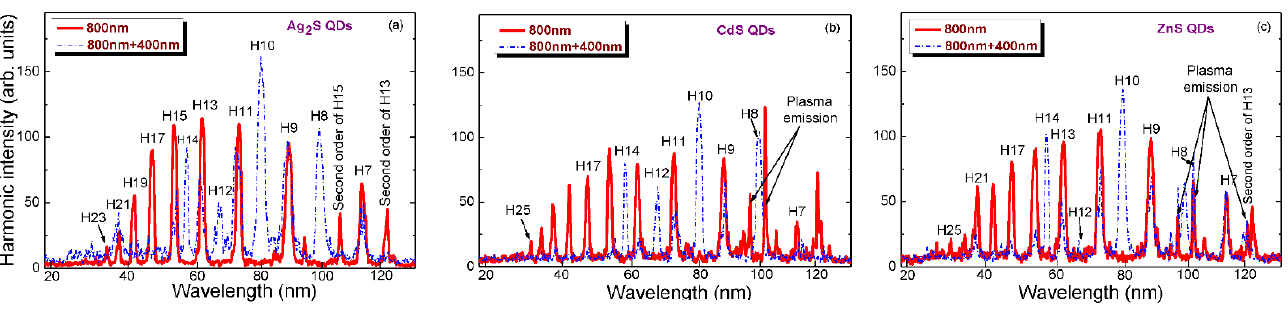
Figure 13. SCP and TCP of ( a ) Ag 2 S, ( b ) CdS, and ( c ) ZnS QDs. Reprinted with permission from Ref. [43], 2018, Optica Publishing Group.